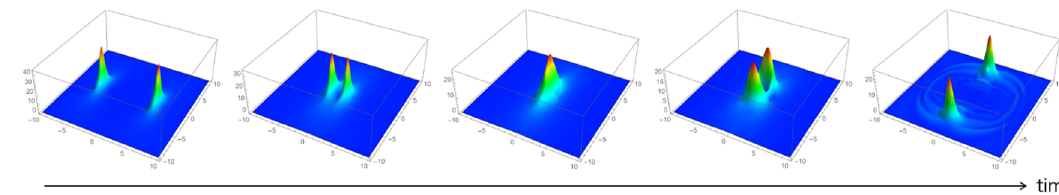
Figure 6 . Evolution of energy density for two parallel vortices scattering with velocities u = 0 . 85 .